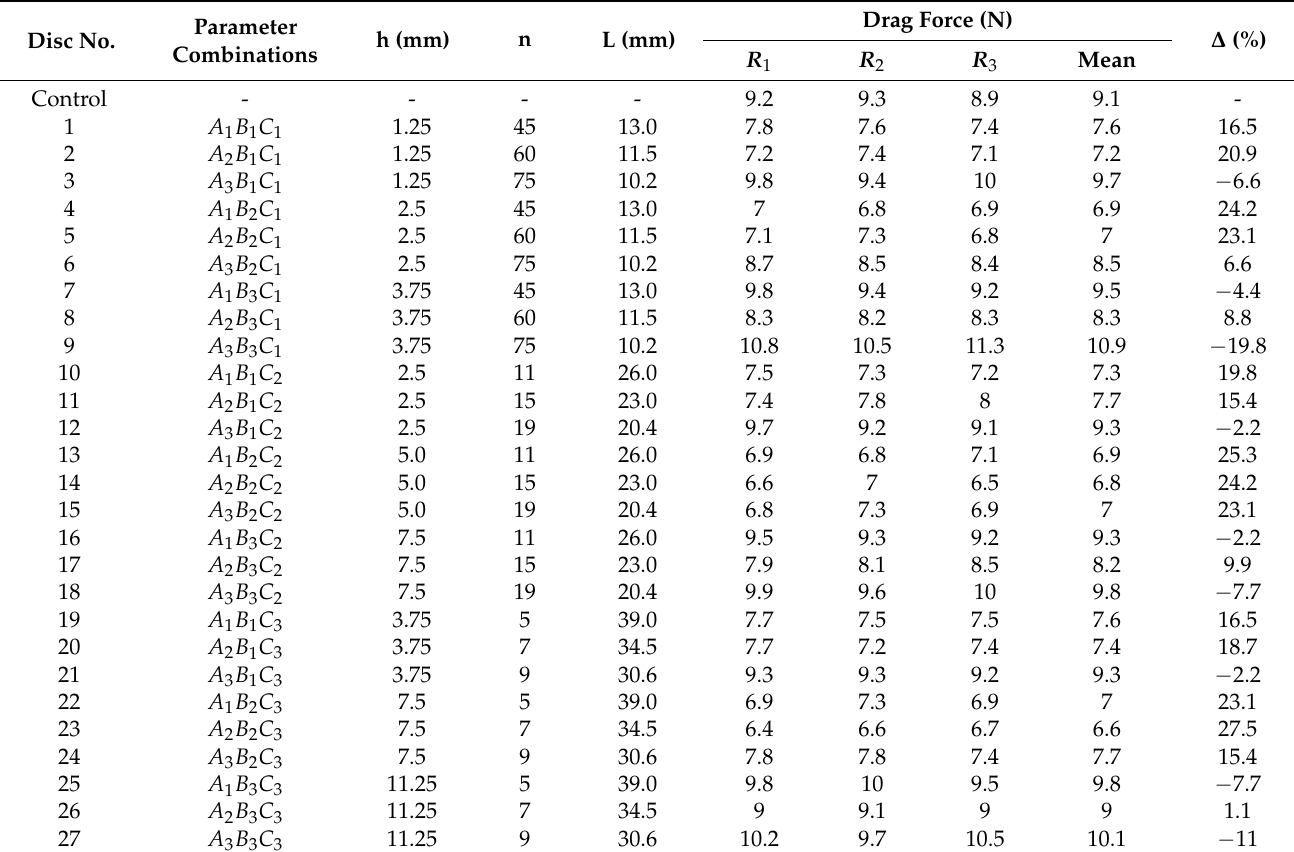
Table 3. The geometrical specifications of test discs and measured values of drag